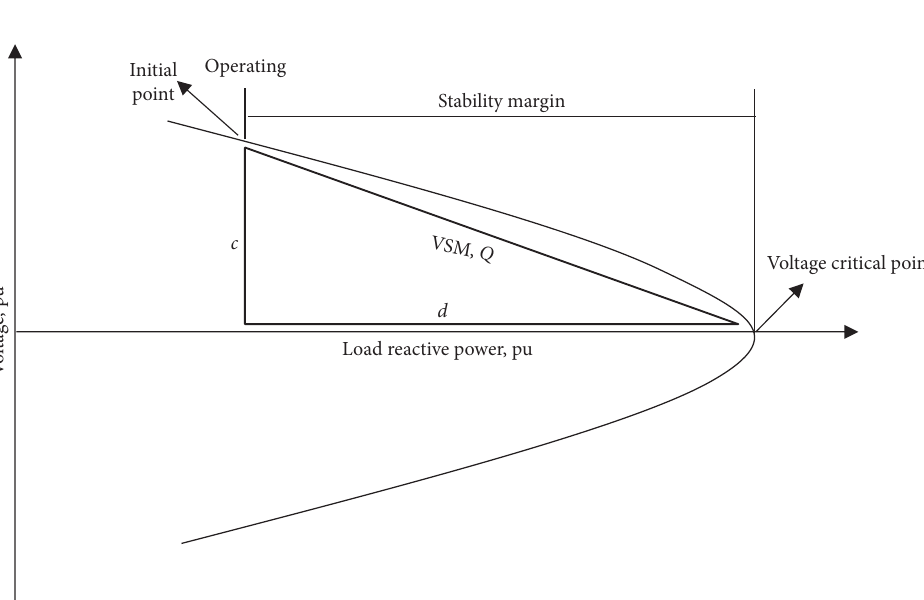
Figure 3: VSM Computation from PV curve.